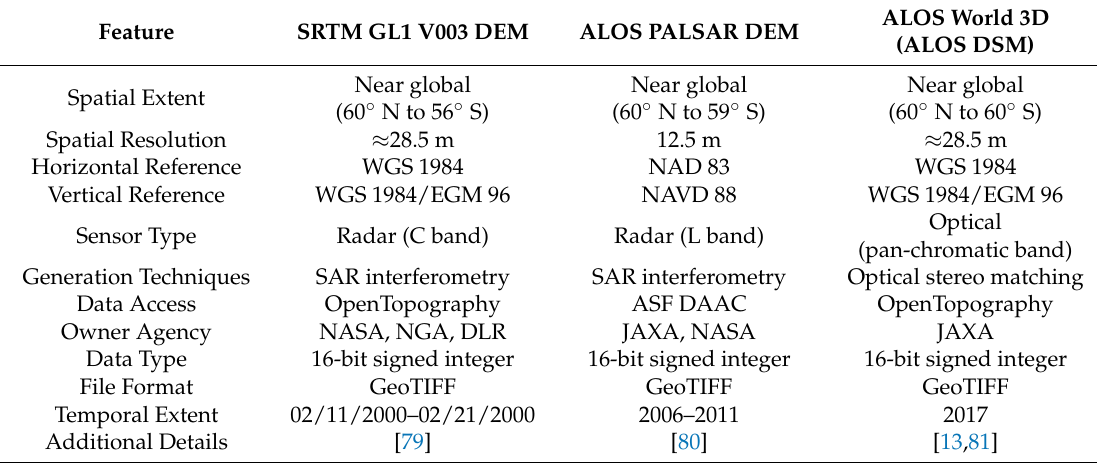
Table 1. Descriptions of the three global Digital Elevation Models (DEMs). SRTM, Shuttle Radar Topography Mission; ALOS, Advanced Land Observing Satellite; PALSAR, Phased Array type L-band Synthetic Aperture Radar; DSM, Digital Surface Model; ASF DAAC, Alaska Satellite Facility Distributed Active Archive Data Center; JAXA, Japan Aerospace Exploration